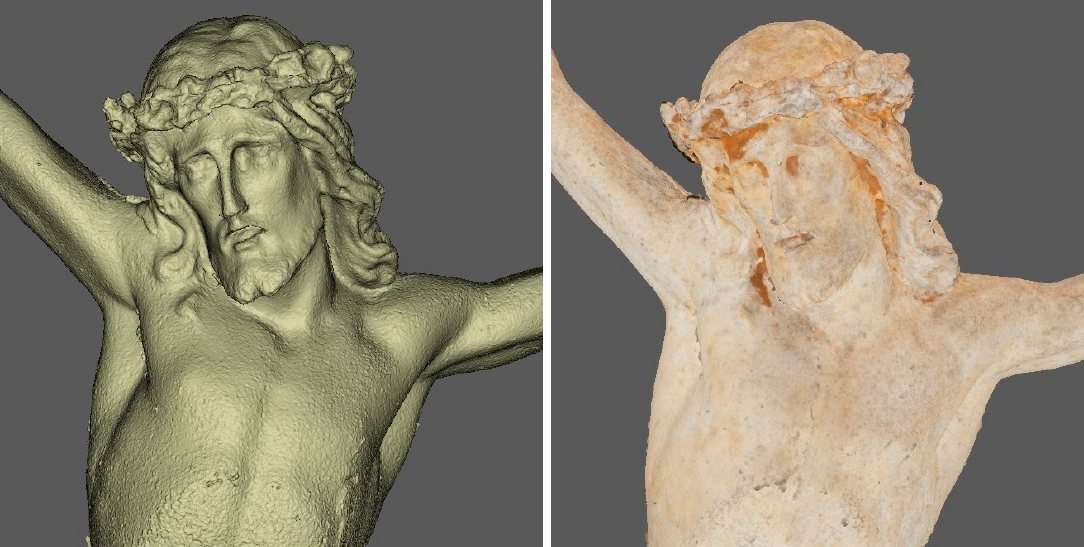
Figure 15. VCM ‐ produced mesh from dataset 9 (smartphone camera).